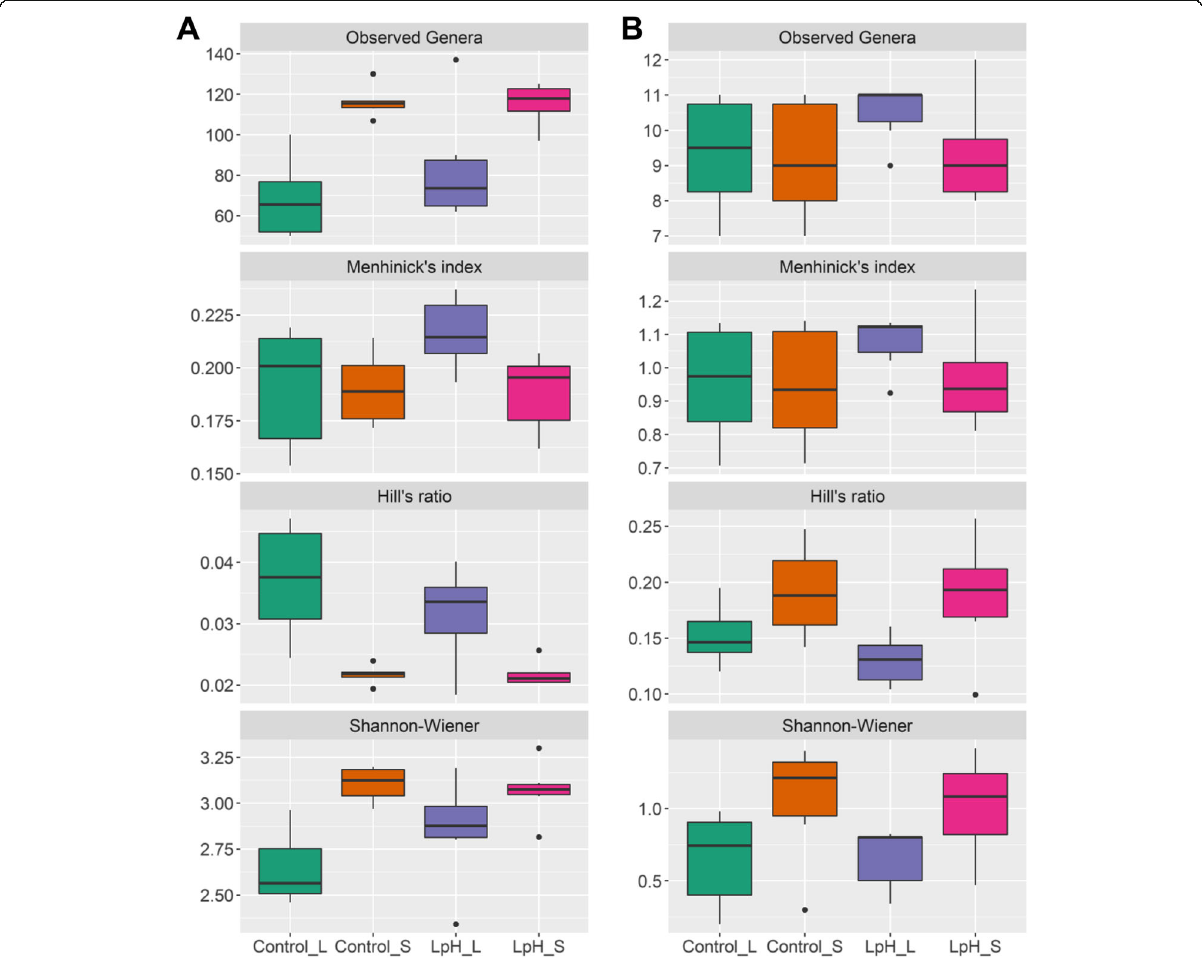
Fig. 1 Effects of sampling phases and ruminal pH on observed genera, index of richness, evenness, and alpha diversity among treatments for bacterial ( a ) and protozoal ( b ) genera. Control_L and Control_S represent ruminal liquid and solid fraction at the Control group, and LpH_L and LpH_S represent ruminal liquid and solid fraction in the acid infusion group with a pH reduction of 0.5